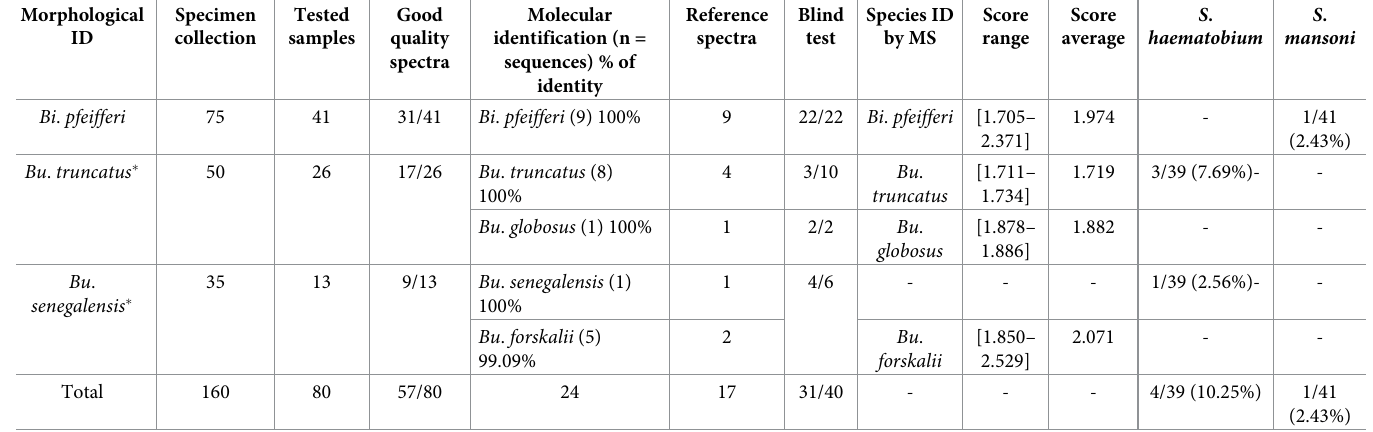
Table 3. Identification results of ethanol-stored snail specimens including schistosomes detection results. Morphological